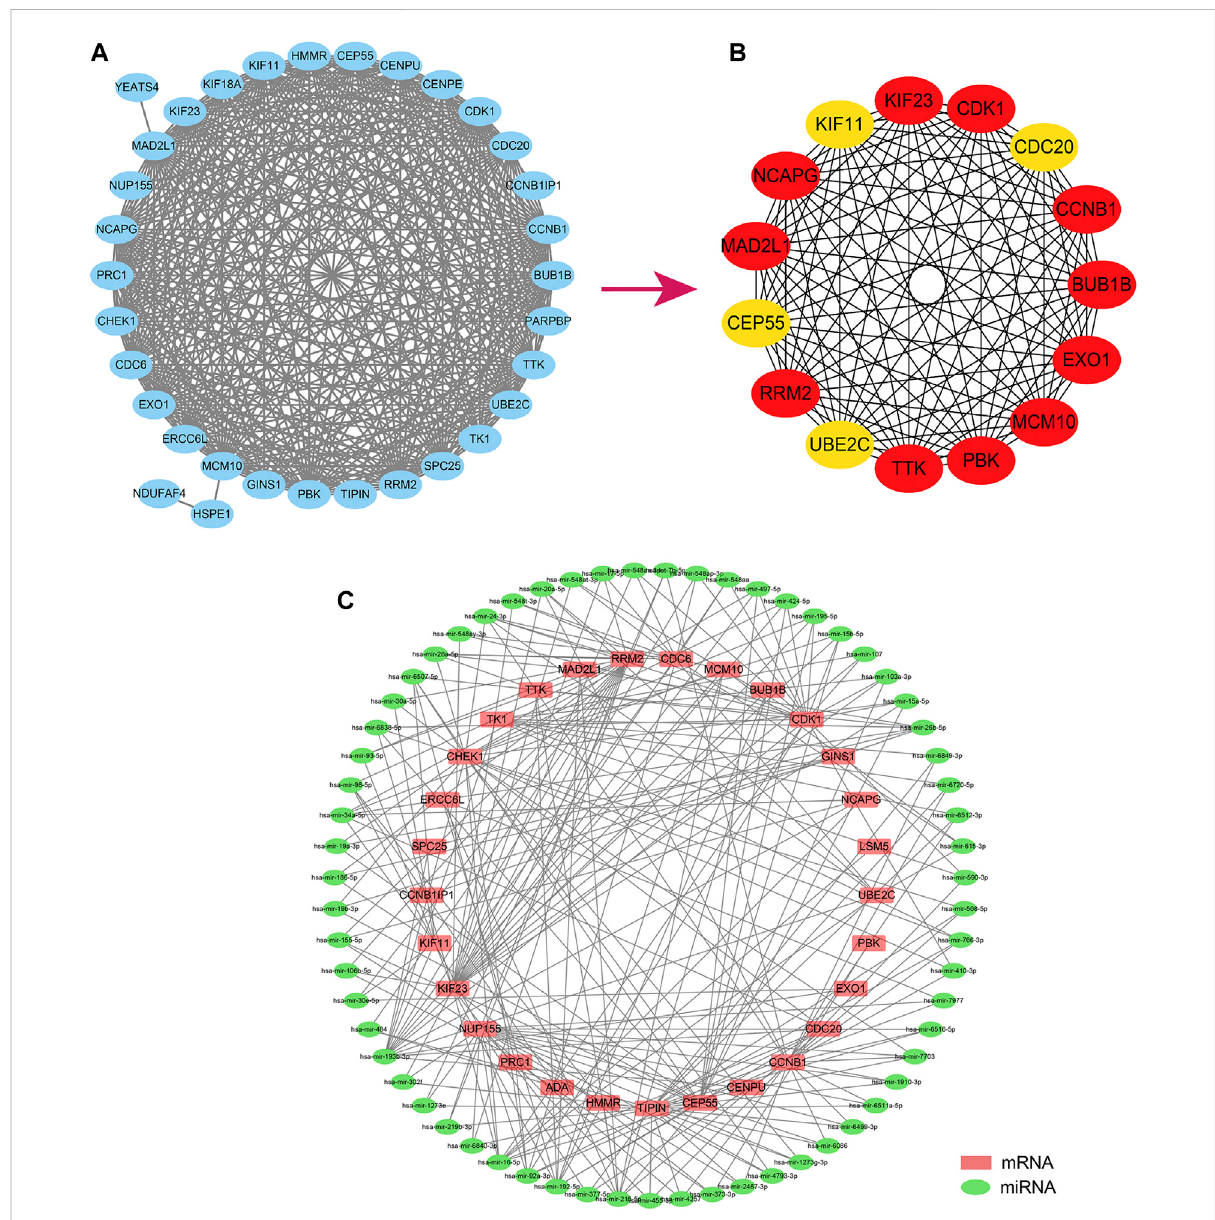
FIGURE 8 Analysis of the Hub gene regulation. (A) . The hub gene establishes the PPI regulatory network. (B) . The Cytohubba plugin further screened fi fteen core genes; (C) . The miRNA-hub gene regulatory network regulates the hub gene predicted according to the Networkanalyst database. PPI, Protein-Protein Interaction